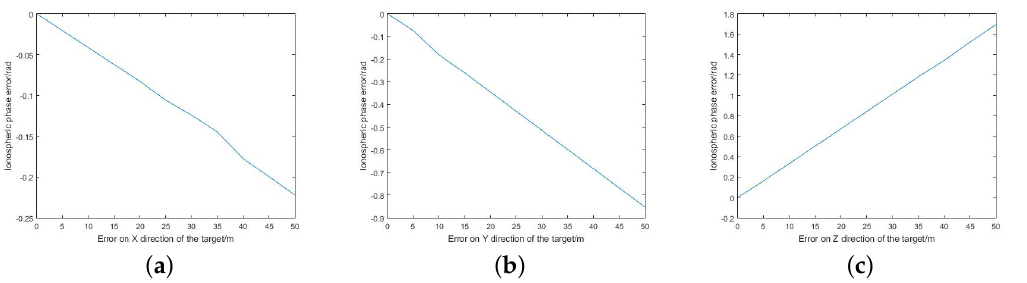
Figure 5. The relationship between error in ionospheric phase and geolocation error on 20080131 and 20080317: ( a ) shows ionospheric phase error when error added in X direction of target coordinate. ( b – c ) are ionospheric phase deviation changing with Y t , Z t